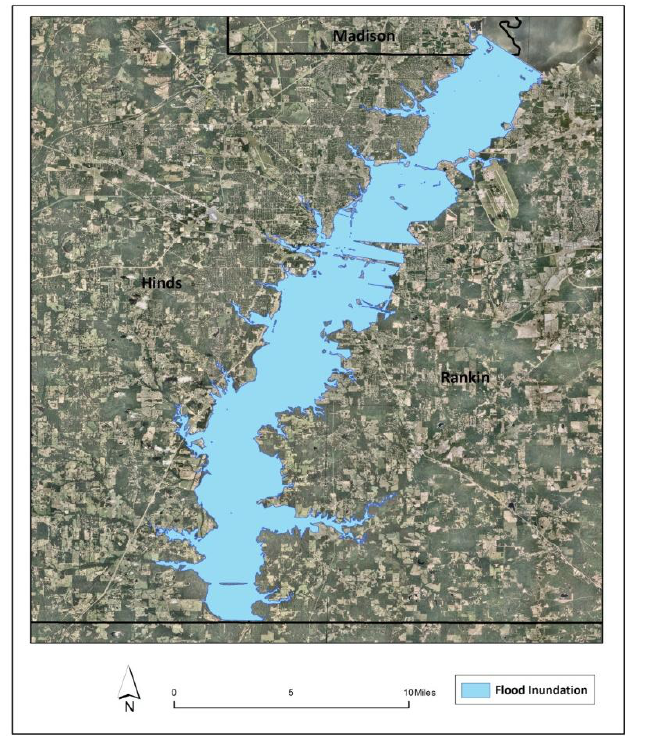
Figure 11. Spatial extent of inundation downstream of Ross Barnett Reservoir.